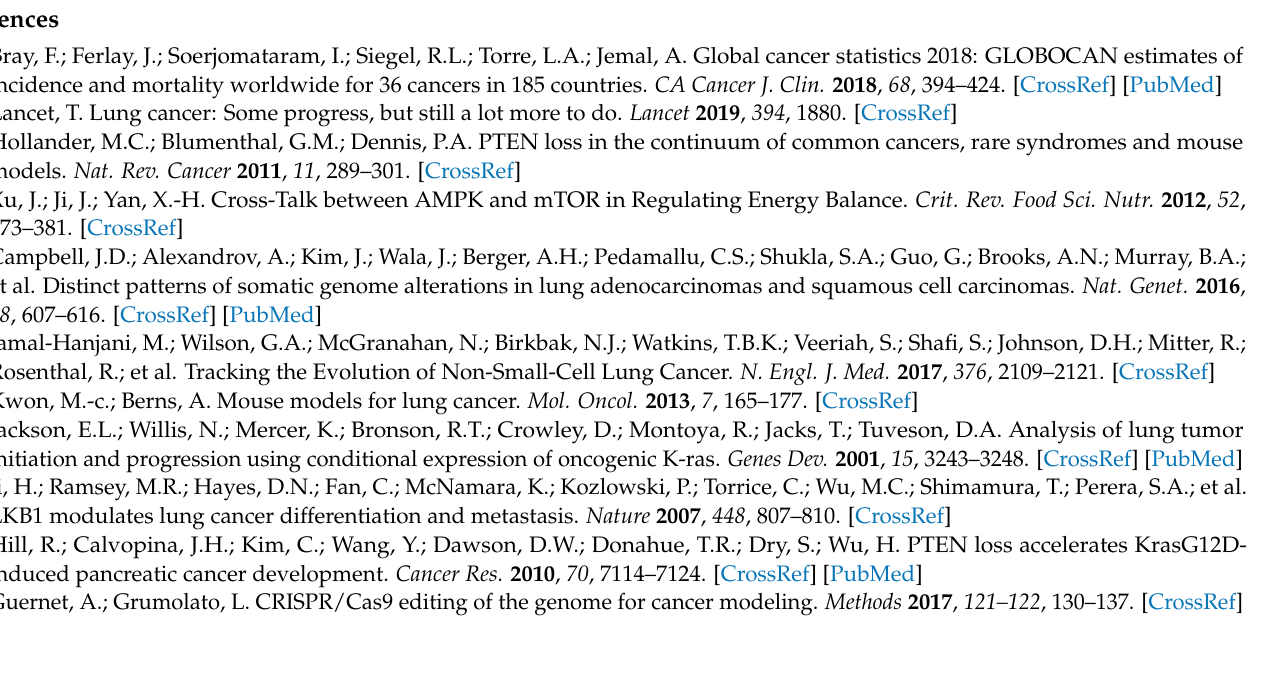
KrasG12D mutation. Figure S4: Detection of KrasG12D mutation in lung tumors induced by CRISPR and HDR. Figure S5: Increase levels of p-Erk in lung tumors. Table S1: Primers and guides